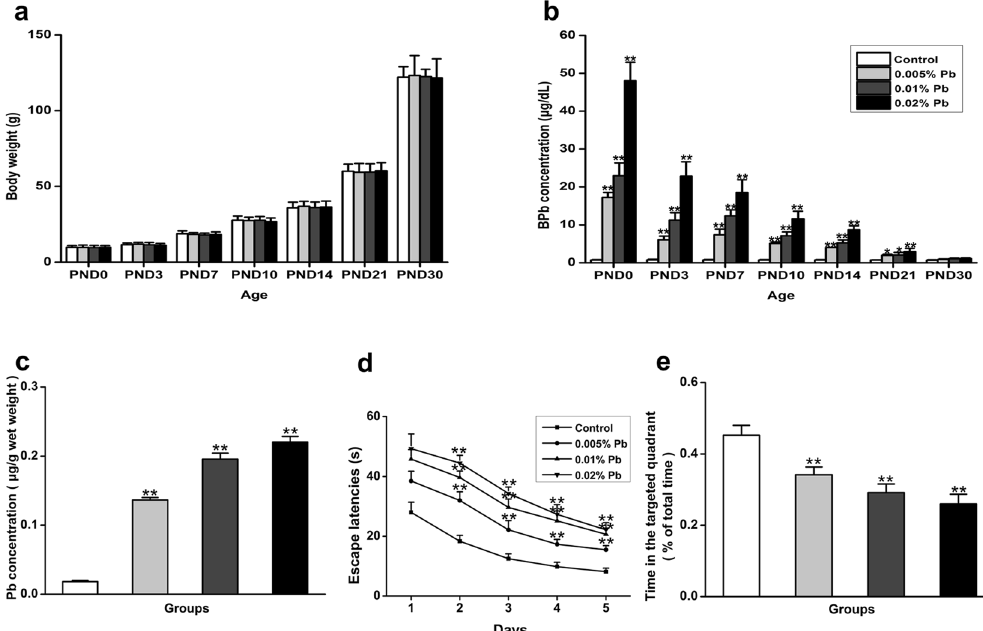
0.005% Pb, 0.01% Pb and 0.02% Pb. ( a ) Body weights (N = 8 per group) and ( b ) blood-lead-levels (BLLs) (N =